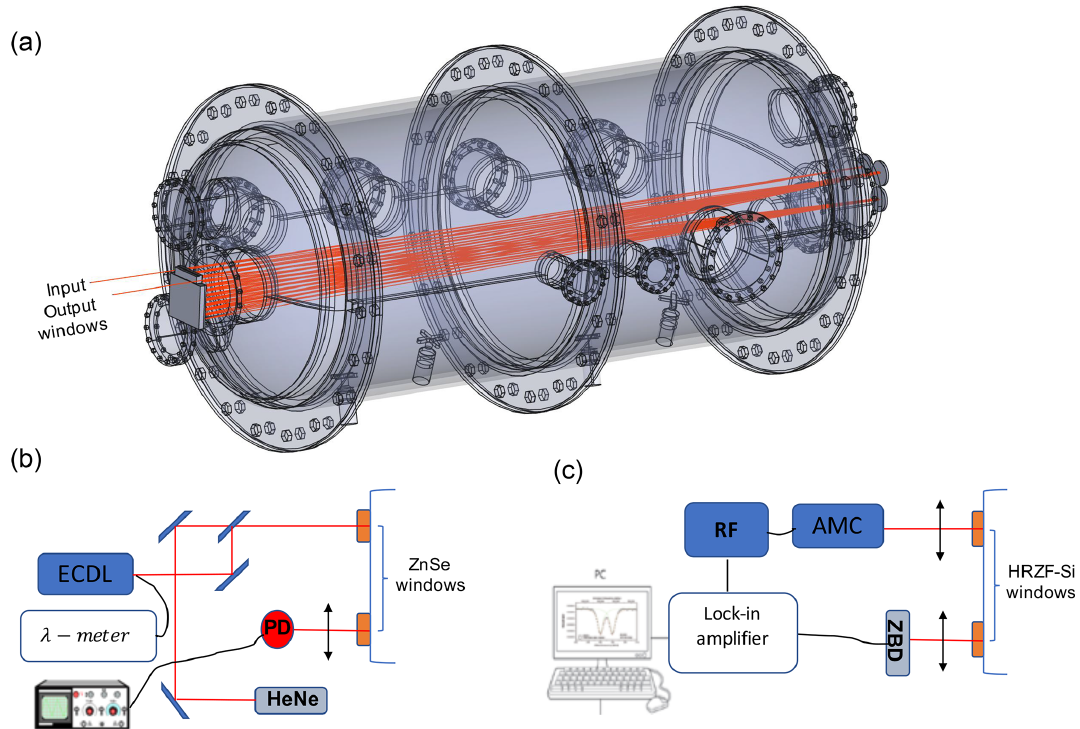
Figure 2. (a) 3D plot of MULTICHARME in CHARME performed with the FreeCad software and the Optics Workbench. (b) Near-IR coupling to MULTICHARME via ZnSe windows using an external cavity diode laser (ECDL), a standard photodiode (PD), a He-Ne laser for alignment and a wavelength meter ( λ -meter). (c) THz coupling to MULTICHARME via high resistivity float zone-silicon (HRFZ-Si) windows using an amplified multiplication chain (AMC) driven by a RF synthesizer and a zero-biased detector (ZBD) connected to a lock-in amplifier.